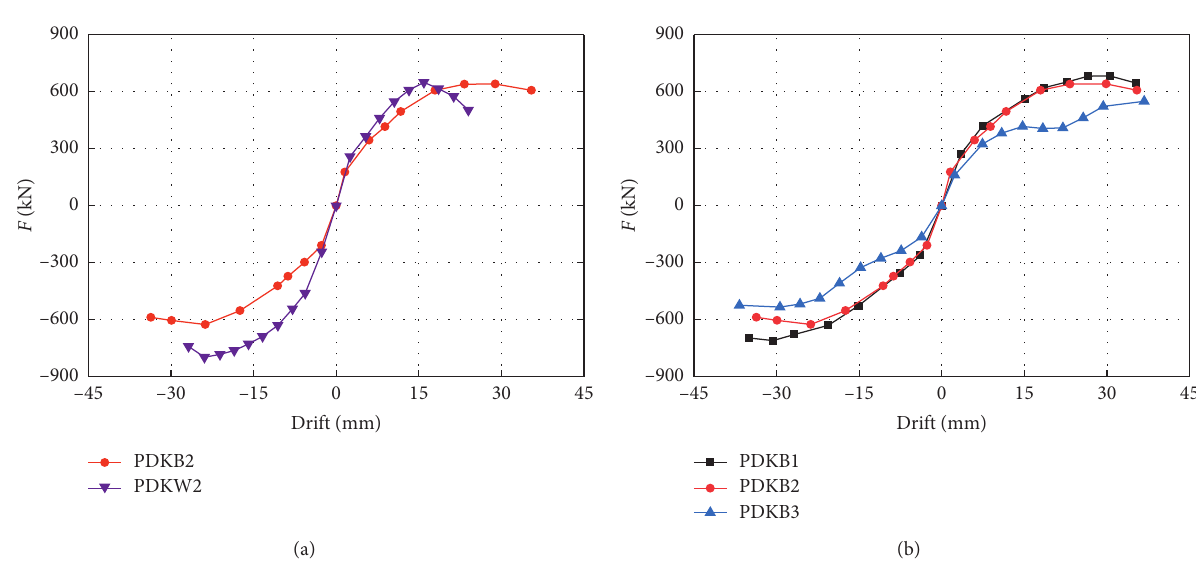
Figure 19: Force-drift envelope curves of